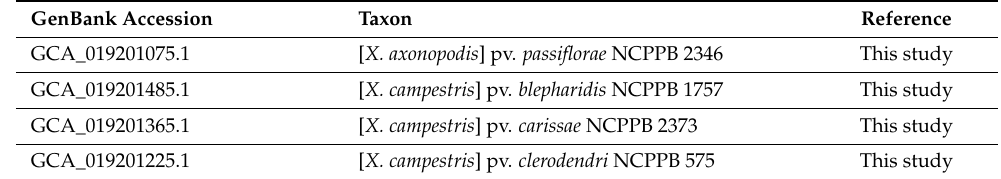
Table A1. Genome sequences used in phylogenomic